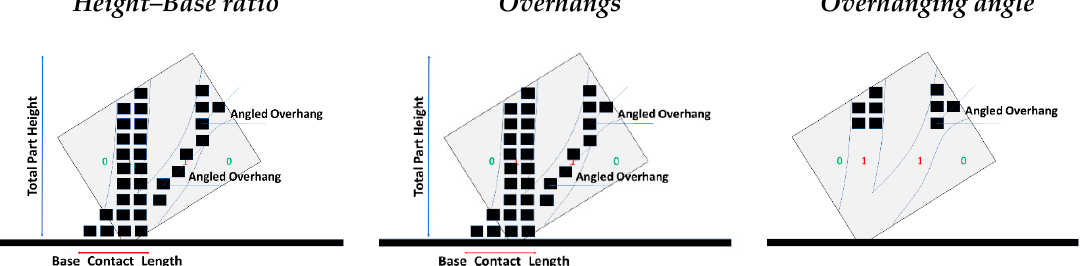
Figure 7. Accounted DfAM rules that will morph the part’s shape.